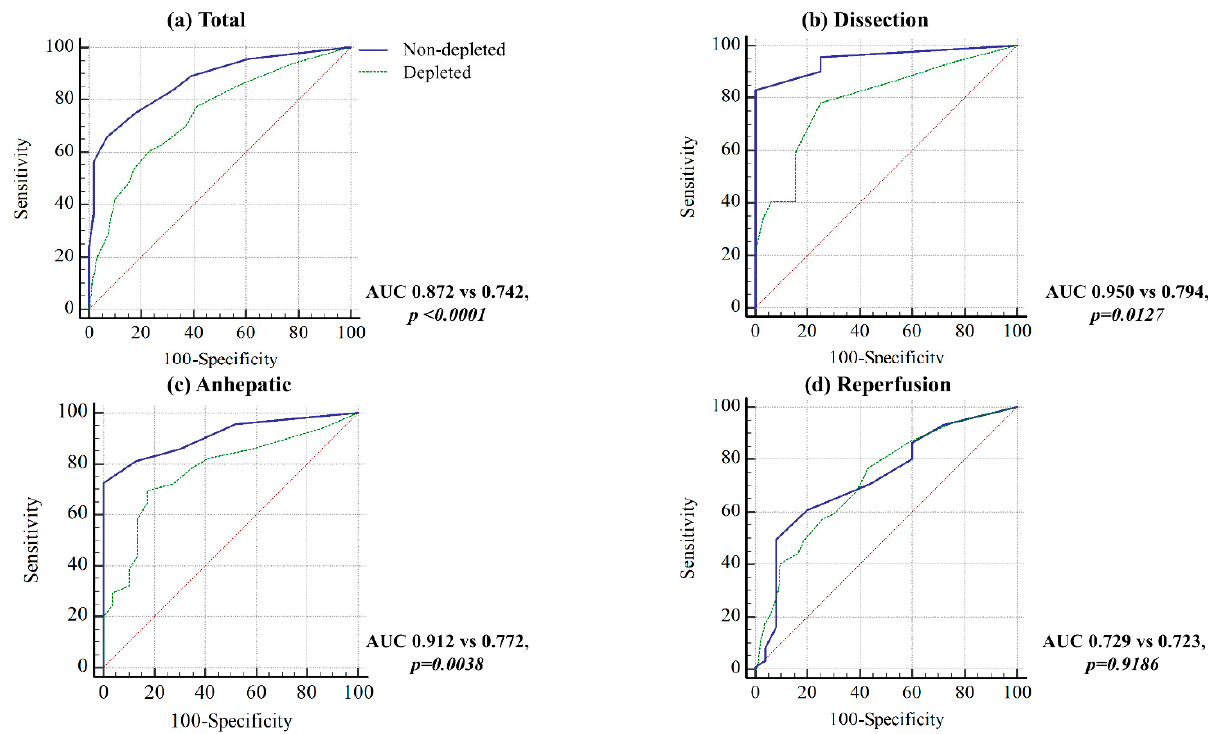
Figure 3. Receiver operating characteristics (ROC) curves of PPV-radial when intravascular volume was depleted (green dotted line) versus non-depleted (blue line). Red dotted line is reference line.